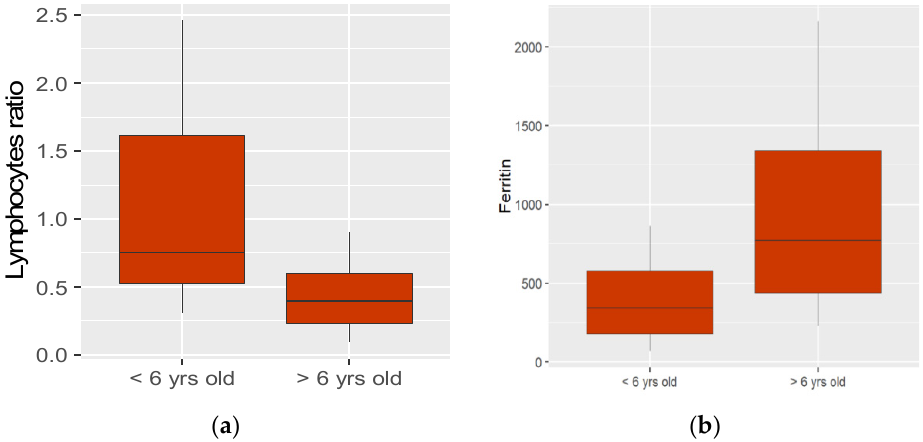
Figure 1. Laboratory findings: lymphocytes ratio and ferritin. ( a ) Lymphocytes ratio between the total lymphocytes and the lower normal limit for age was statistically significantly lower in group 2 ( ≥ 6 years) than in group 1 (<6 years); ( b ) Ferritin statistically significantly higher in group 2 ( ≥ 6 years) than in group 1 (<6 years). Yrs old: years old. Table 2. Laboratory findings in the MIS-C cohort according to different age groups. Group 1: <6 years old (No. 13); group 2: ≥ 6 years old (No. 12). Reported only significant p values (<0.05).